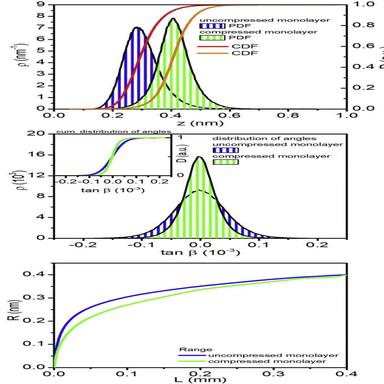
The statistical analysis of 5CB liquid crystal (left column) and 5CB/CNC nanocomposite (right column) surface at the air-water interphase; the probability distribution of height (a), the probability distribution of angles of LC molecules (b), and calculated range (c).